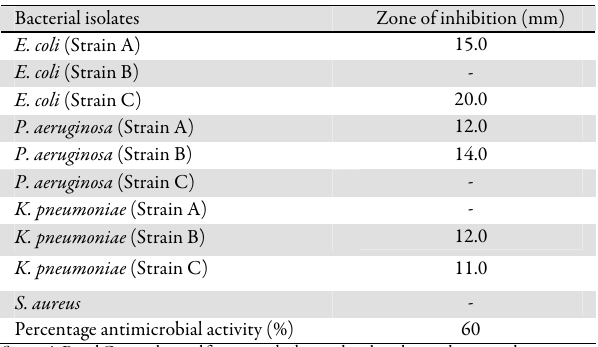
Table 2. Antibacterial activity of the laccase biosynthesized AgNPs using UV 10 strain of L. edodes Bacterial